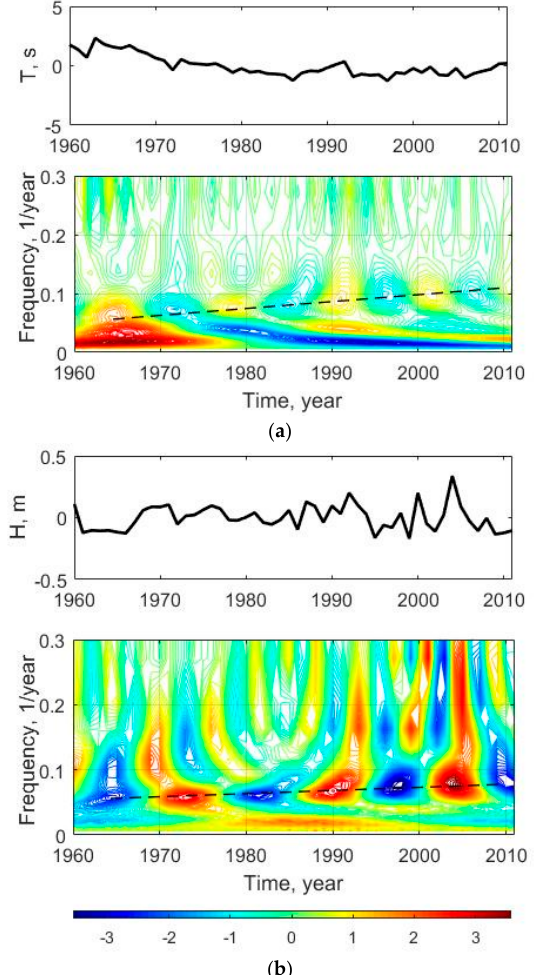
Figure 3. Wavelet transforms of the average annual wave periods ( a ) and heights ( b ). For wavelet analysis, the mean values of the time series were deleted.